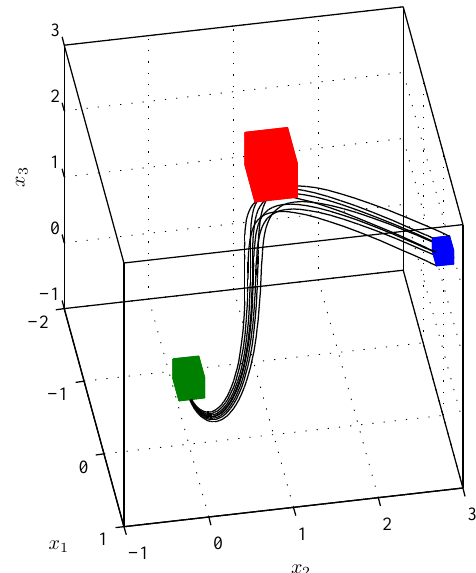
Figure 8: The blue box illustrates the initial states of the system, the red box illustrates the unsafe states, and the green box illustrates the goal states. A set of system trajectories are drawn with black